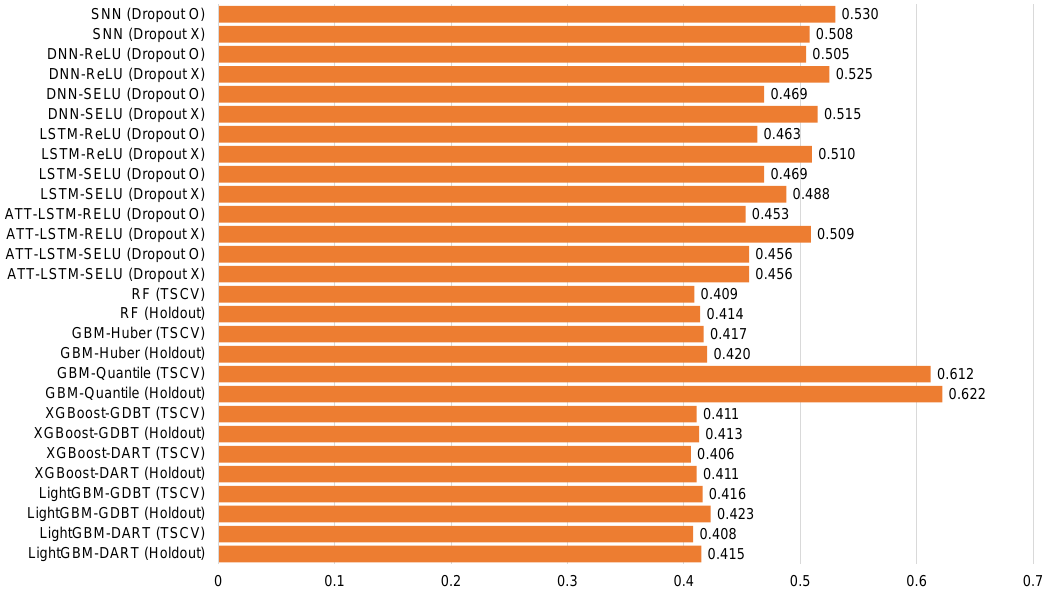
Feature importance is a measure of variable importance when data have obtained a subset of